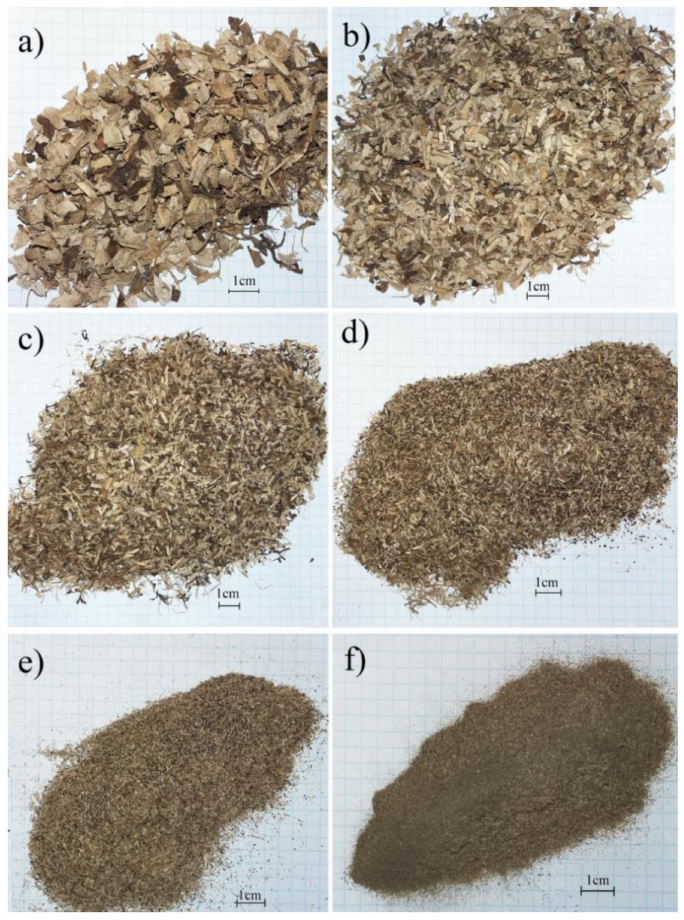
Figure 4. View of individual fractions of shredded post-harvest tobacco waste (own source): ( a ) 4 mm fraction, ( b ) 2 mm, ( c ) 1 mm, ( d ) 0.5 mm, ( e ) 0.25 mm and ( f ) < 0.25